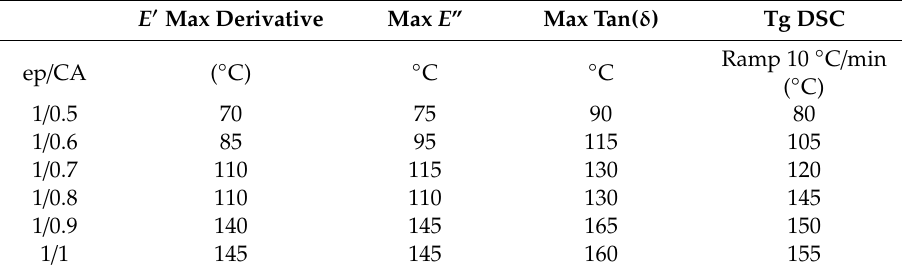
Table 2. Glass transition temperature of epoxide thermosets.